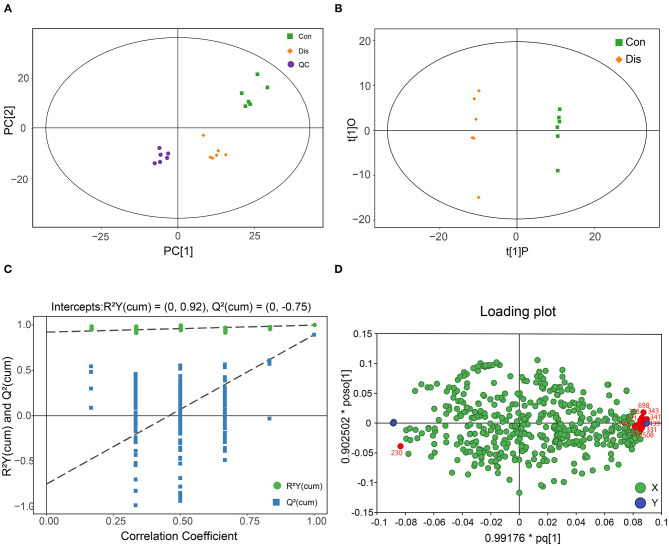
Metabolic profile of chicken infected with NIBV obtained through GC-TOF/MS-based metabolomics. (A) The plot of the PCA model. (B) The scatter plot of the OPLS-DA model. (C) The plot of the 200-permutation test of the OPLS-DA model. (D) Loading plot of the bursa of Fabricius samples obtained from chickens, and red points indicate the potential biomarkers.